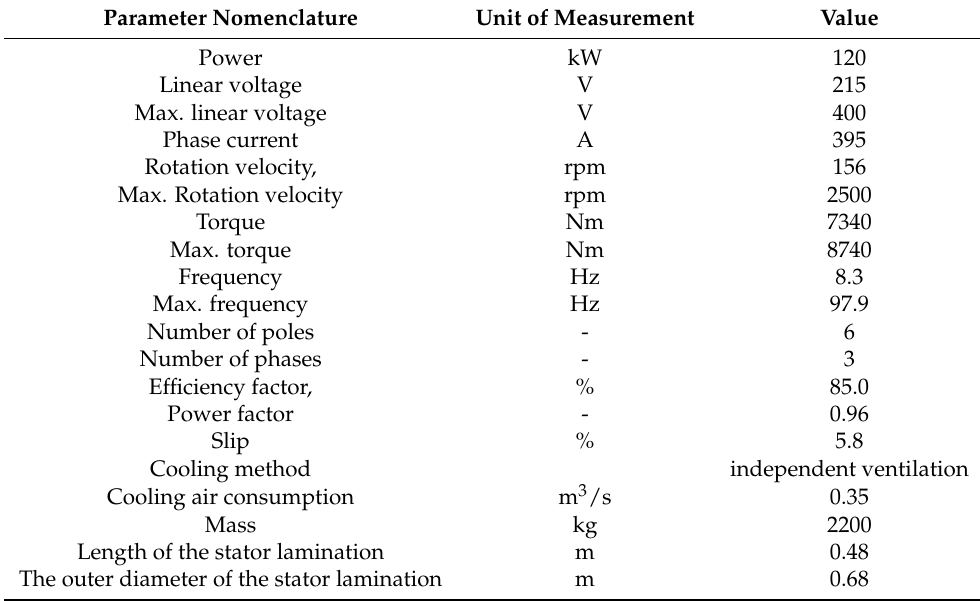
Table 4. Rated technical parameters of the traction induction motor.